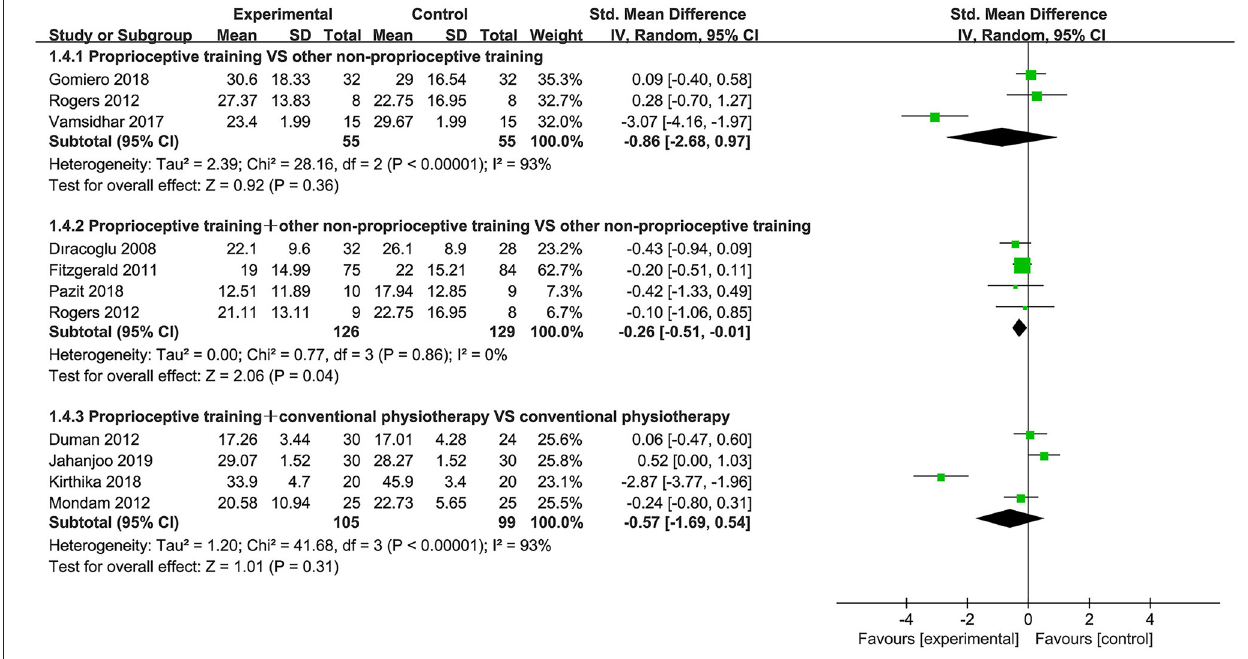
FIGURE 5 | Forest plot of meta-analysis on WOMAC (total)